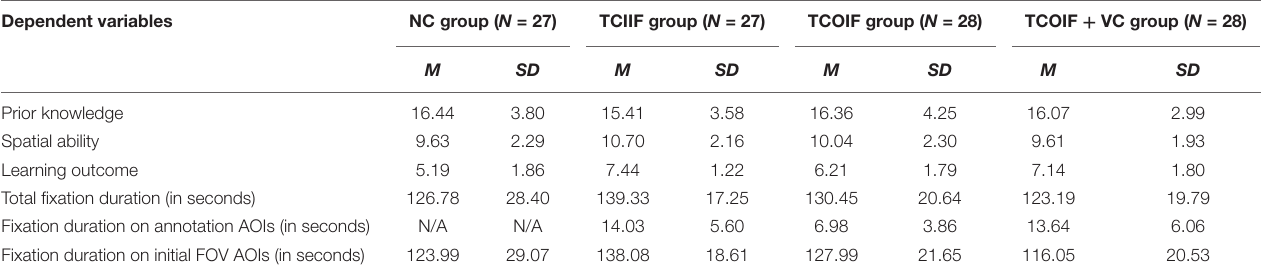
TABLE 1 | Descriptive data for all variables under the four